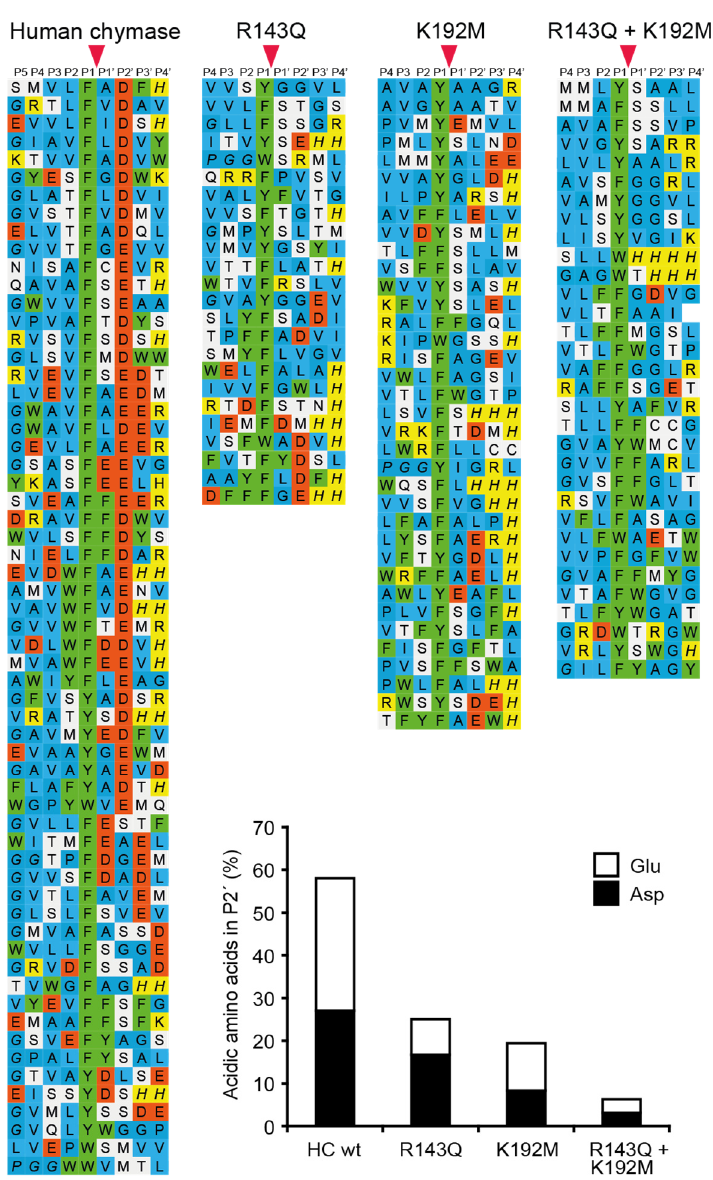
Figure 5. Phage display results for the analysis of the importance of Arg143 and Lys192 in the human chymase for the selection of negatively charged amino acids in the P2´position of substrates. In the bottom of the figure a diagram of the percentage of negatively charged amino acids found in the P2´position of different phages isolated from the phage display with the wild type enzyme, the two single mutants and the double mutant. The relative distribution between the two negatively charged amino acids, Asp and Glu, is also shown by black or white fields. The amino acids in the phage display results are color coded as shown in Figure 4. The cleavage by the enzyme occur after the P1 residue as marked by red arrow heads. The figure contains data from two earlier publications [33,39].